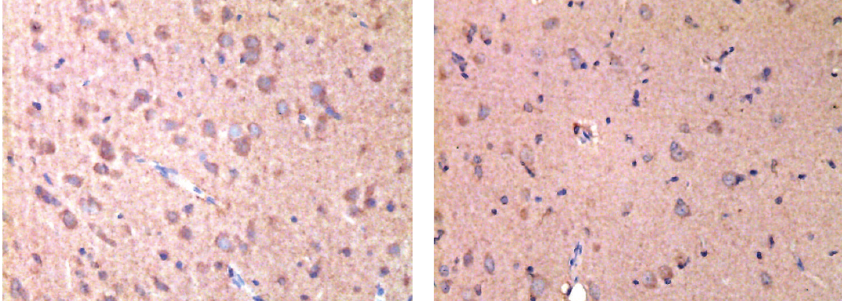
Figure 3: Immunohistochemical study of TLR4, NF- κ B, and MCP-1 on brain samples in (scale bar, 100 μ m). The arrows show the positive neurons.